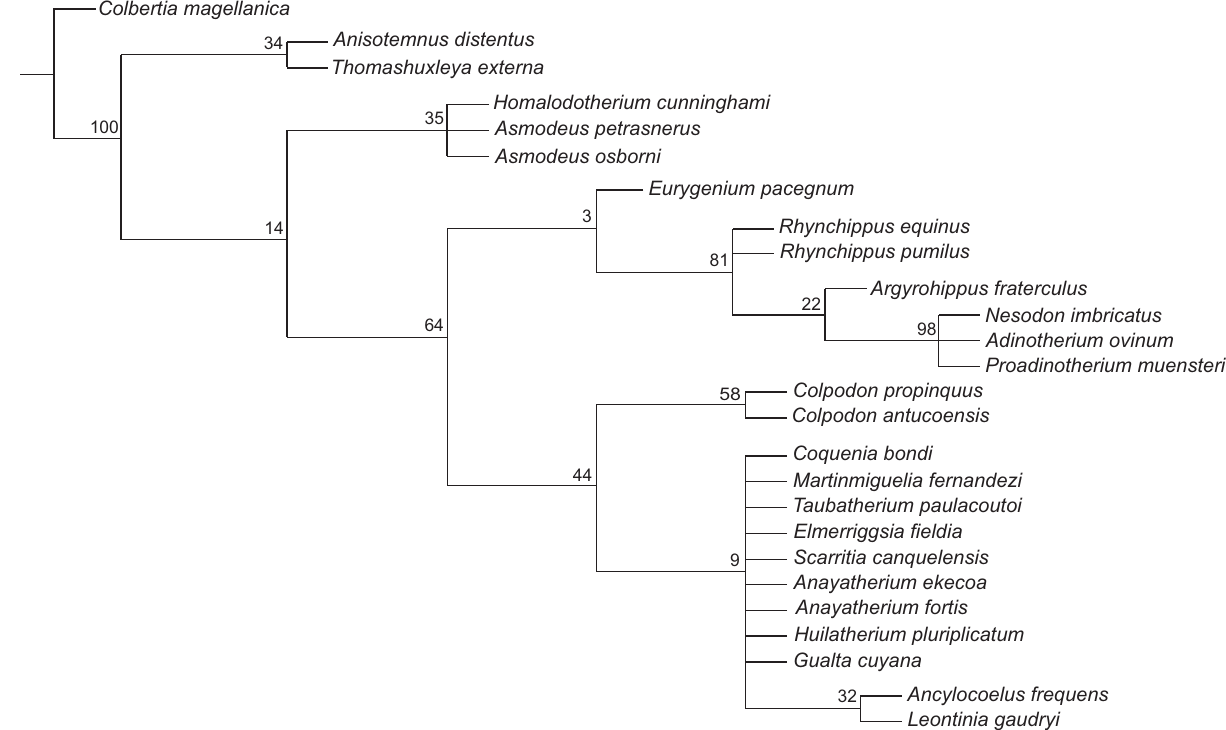
Fig. 9. Strict consensus tree from phylogenetic analysis under extended implied weighting with 21 different values of